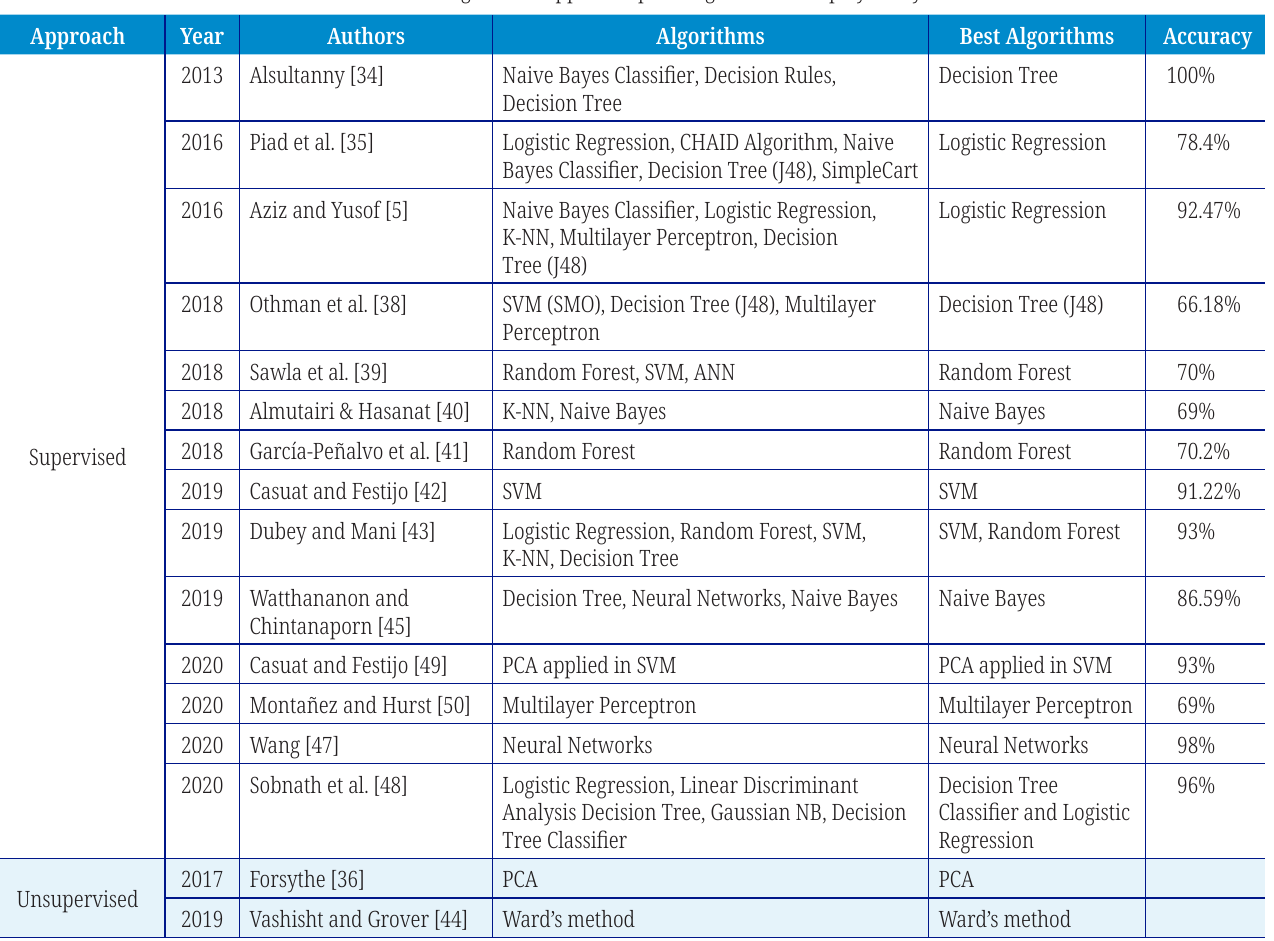
Table 5. ML algorithms applied to predict graduates’ employability